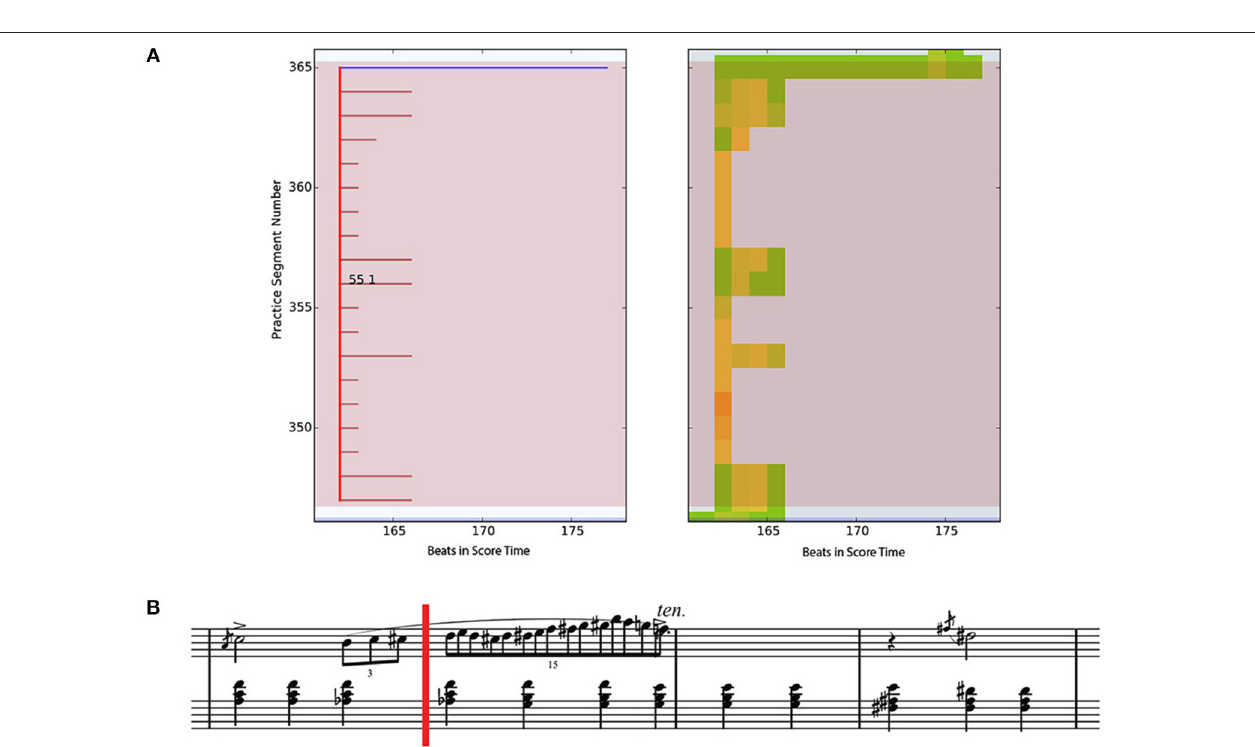
FIGURE 11 | Practice Segment Work Map (top left) and Practice Segment Precision Map (top right) for a Drill-Correct practice pattern by E-1; corresponding music segment is shown in the score (lower part of figure). (A) Left - Practice Session Work Map with color annotations of drills (dark red) and smooth (blue). Right - Practice Session Preci-sion Map with color annotations of correct (green) and incorrect (red) beats. (B) Corresponding score. The point of interest starts at the red vertical line (m. 55 beat 1).